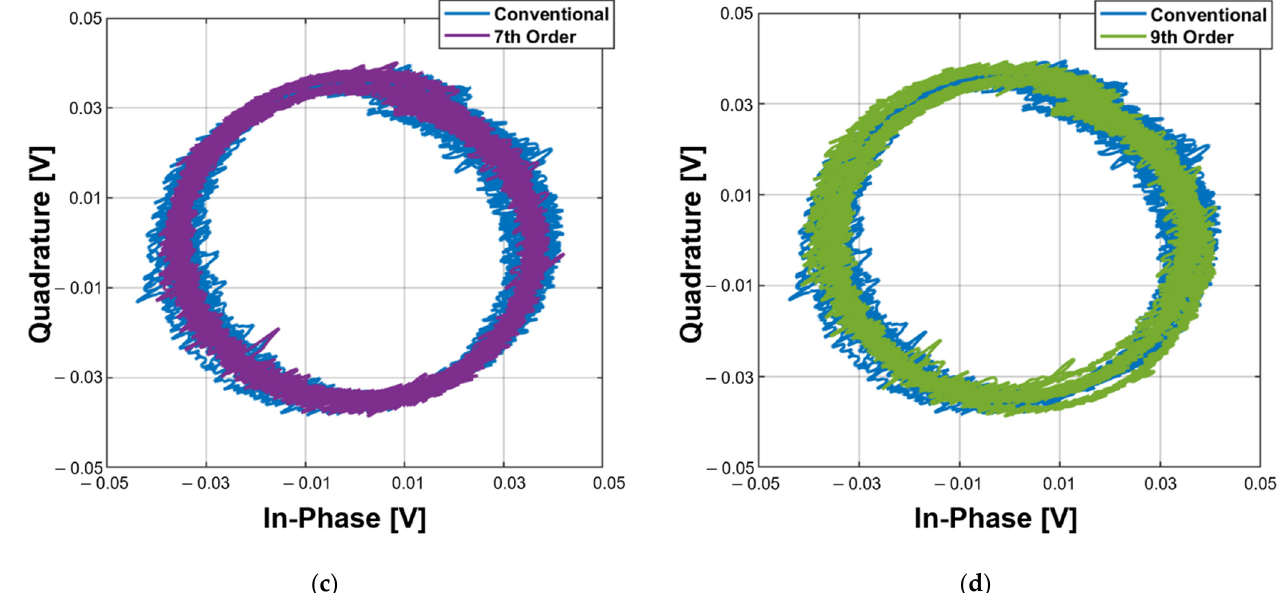
Figure 10. I/Q plots in the displacement measurement obtained by the circle fitting method after processing the conventional static DC offset cancellation and the proposed detrending technique depending on the order of the polynomial fitting: using the polynomial with ( a ) third order; ( b ) fifth order; ( c ) seventh order; ( d ) ninth order.